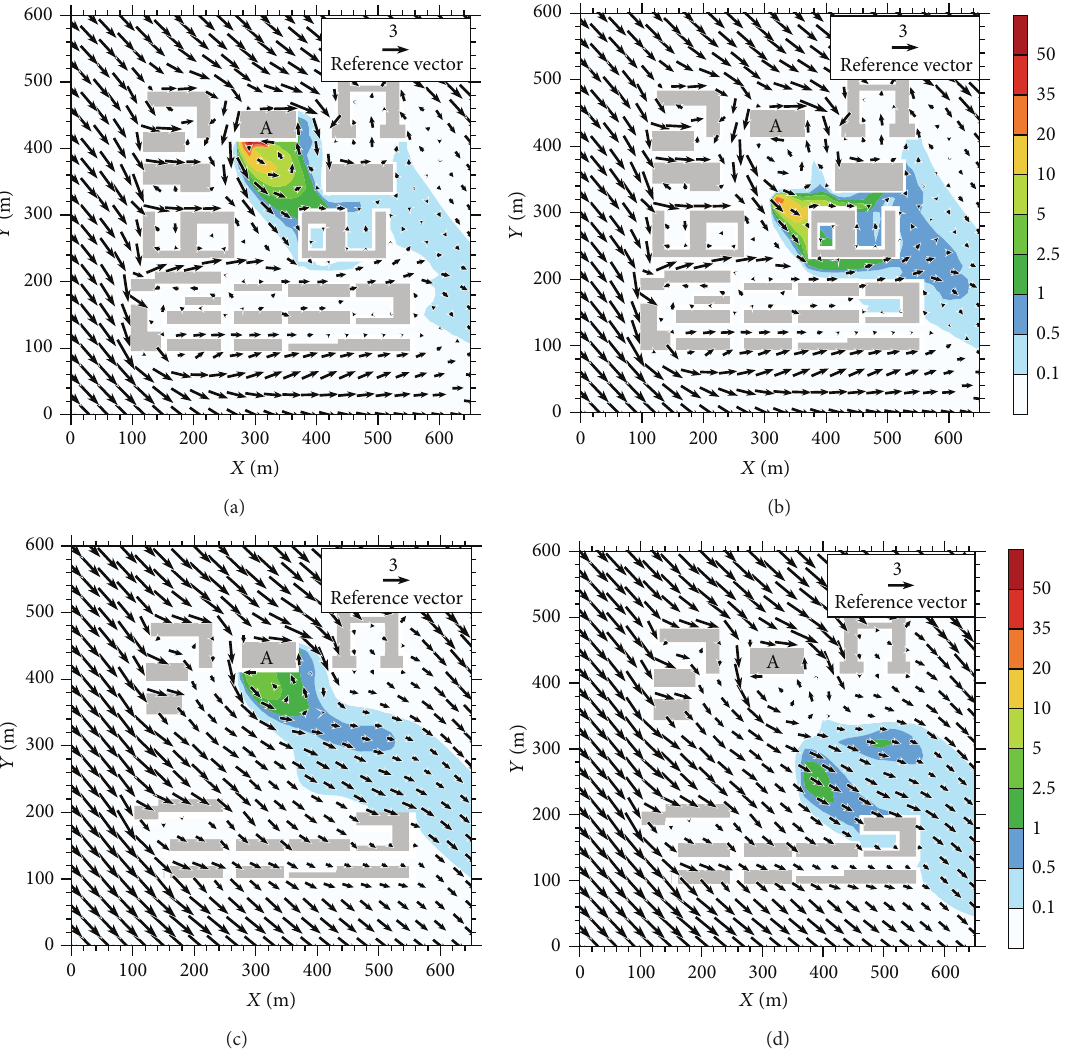
Figure 7: Simulated concentration (ppm) and wind vector fields at 1400 LST on 16th of February: (a, b) at 𝑧 = 2.5 m; (c, d) at 𝑧 = 22.5 m; (a, c) the point source was located at P1; (b, d) the point source was located at P2.